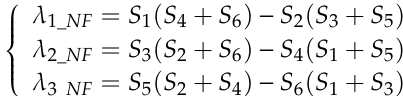
Table 2. The relationship between switching states and phase voltages under healthy conditions. State #